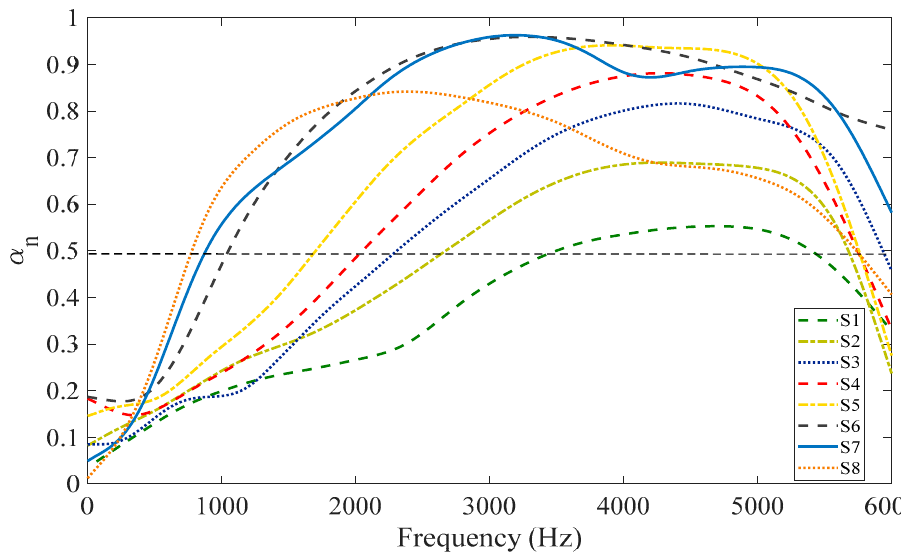
Figure 8. The sound absorption coefficient of woven fabric S1–S8 for normal incidence wave. Table 4. The peaks and absorption bandwidth of each sample .